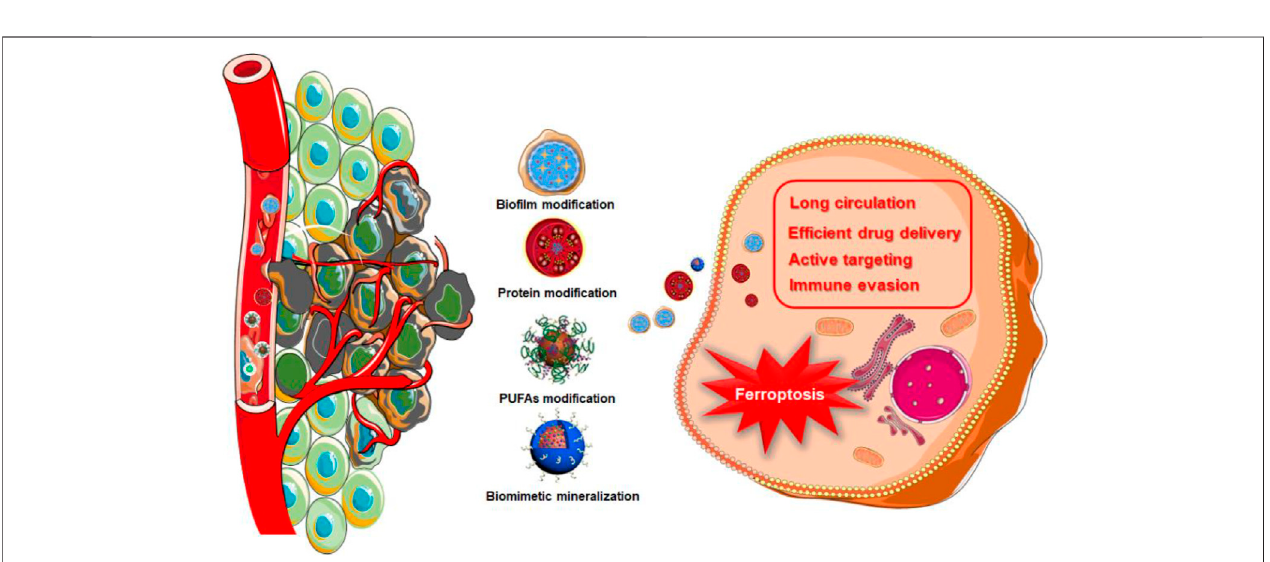
FIGURE 1 | Schematic illustration of biomimetic nanomaterials for inducing ferroptosis.